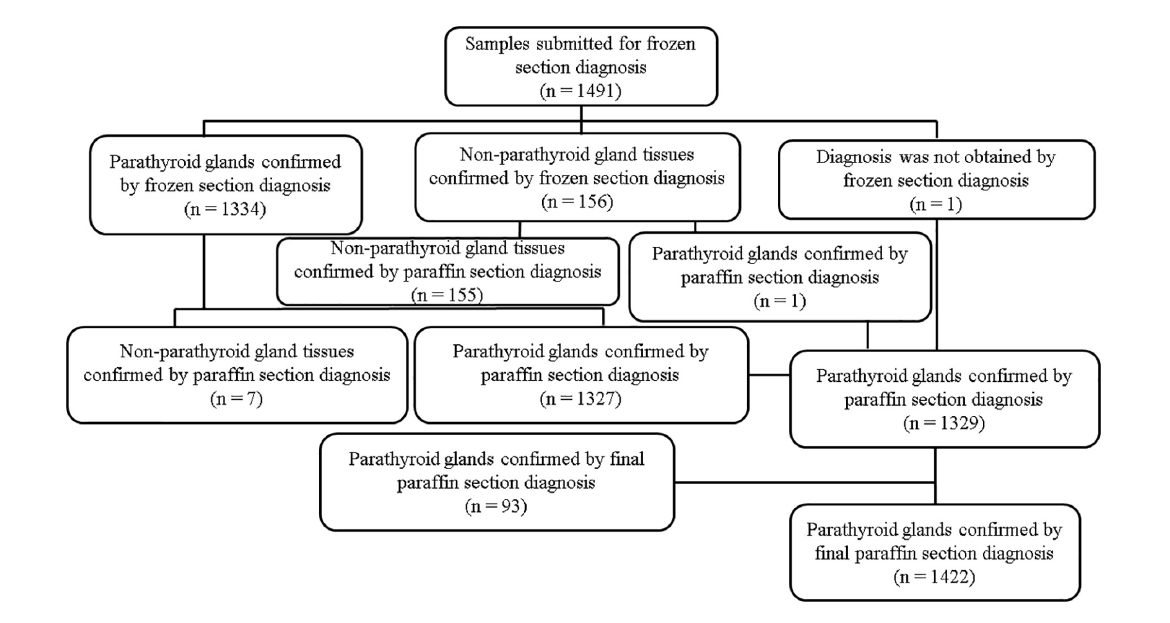
FIGURE3 Number of samples submitted for frozen section diagnosis and pathological diagnosis. n = number of